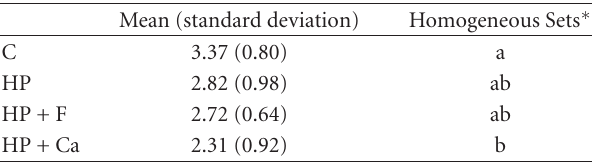
Table 1: Mean (standard deviation) of the erosive enamel wear ( µ m) for the di ff erent tested